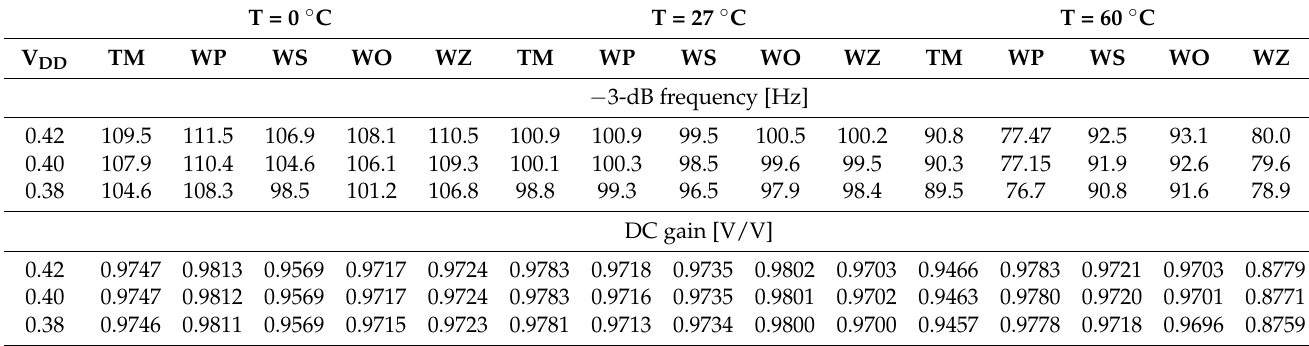
Table A1. Process (CMOS 180 nm X-FAB) corner simulation results for the ladder-based filter in Figure 7c. T = 0 ◦ C T = 27 ◦ C T = 60 ◦ C